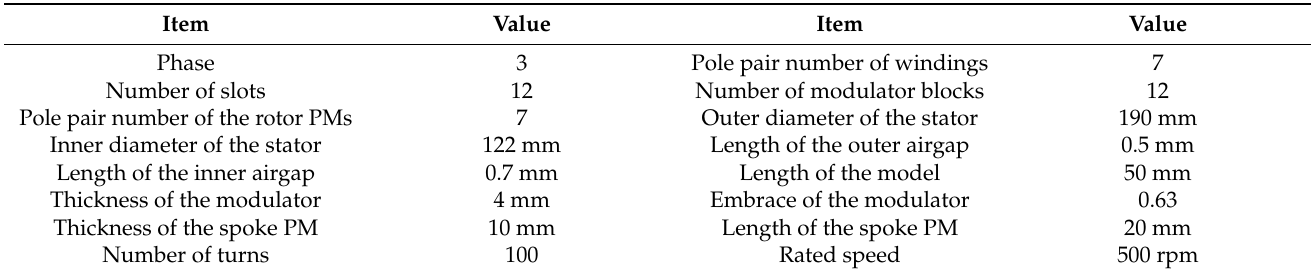
Table 7. Design parameters and dimensions of the selected model.